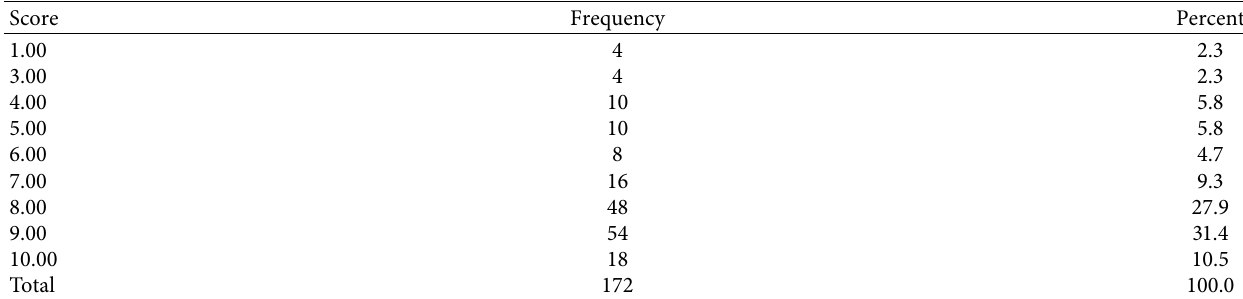
Table 6: Project scope visual analogue scale data.